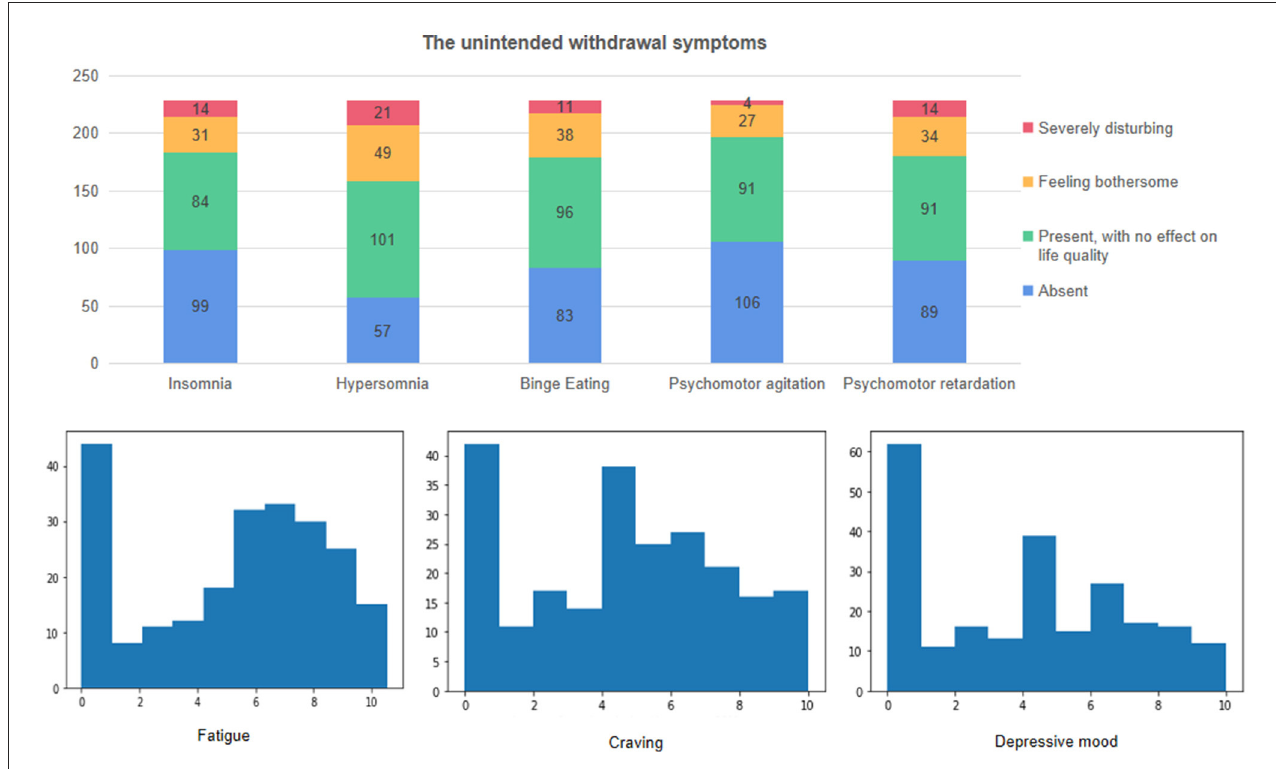
FIGURE2 Unintended withdrawal symptoms were reported by the